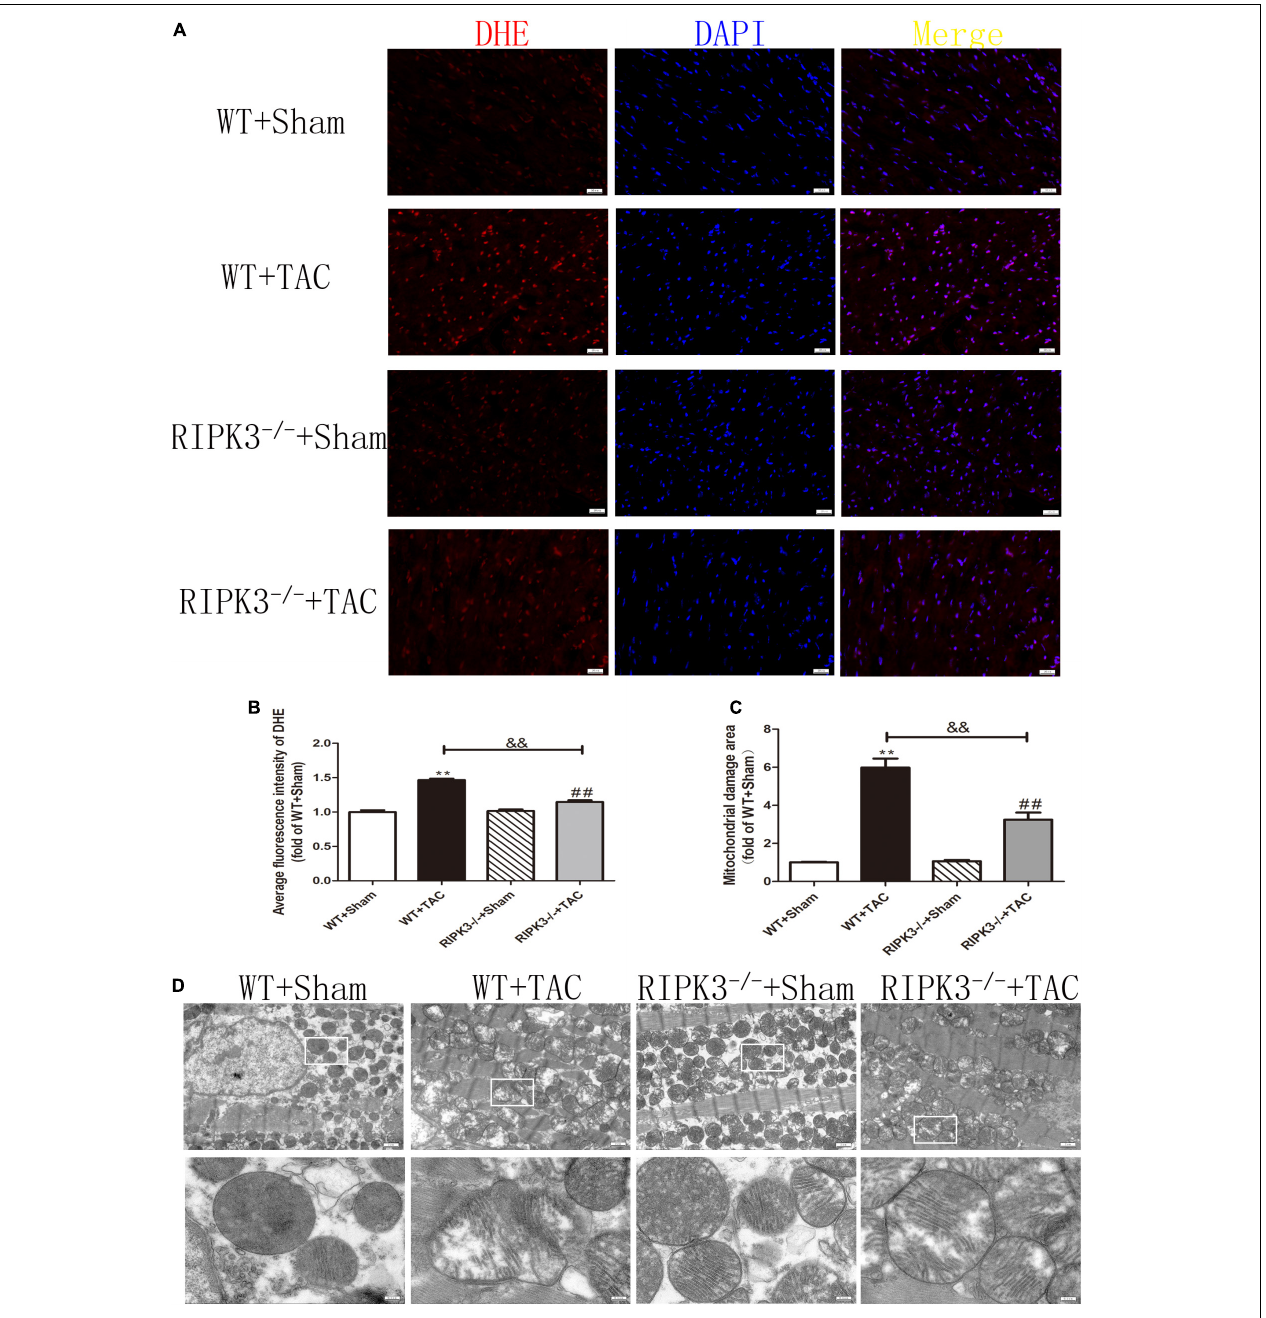
FIGURE 8 | Depletion of RIPK3 can reduce ROS accumulation in myocardial tissue of HF mice and improve antioxidant capacity and mitochondrial structural abnormalities. Male 8-week-old WT and RIPK3 − / − mice were treated with TAC using a 28-g needle. The control group received sham surgery. All groups of mice were given continuous feeding for 6 weeks. Hearts were then obtained for correlative testing. (A) DHE staining, bar = 50 µ m. (B) Average fluorescence intensity measurements of DHE. (C) Mitochondrial damage area. (D) The ultrastructure of LV mitochondria was observed by transmission electron microscope, bar = 2 µ m. Lower picture bar = 0.5 µ m. Compared with WT + sham group, ** P < 0.01; compared with RIPK3 − / − + sham group, ## P < 0.01; compared with WT + TAC group, && P < 0.01. n =